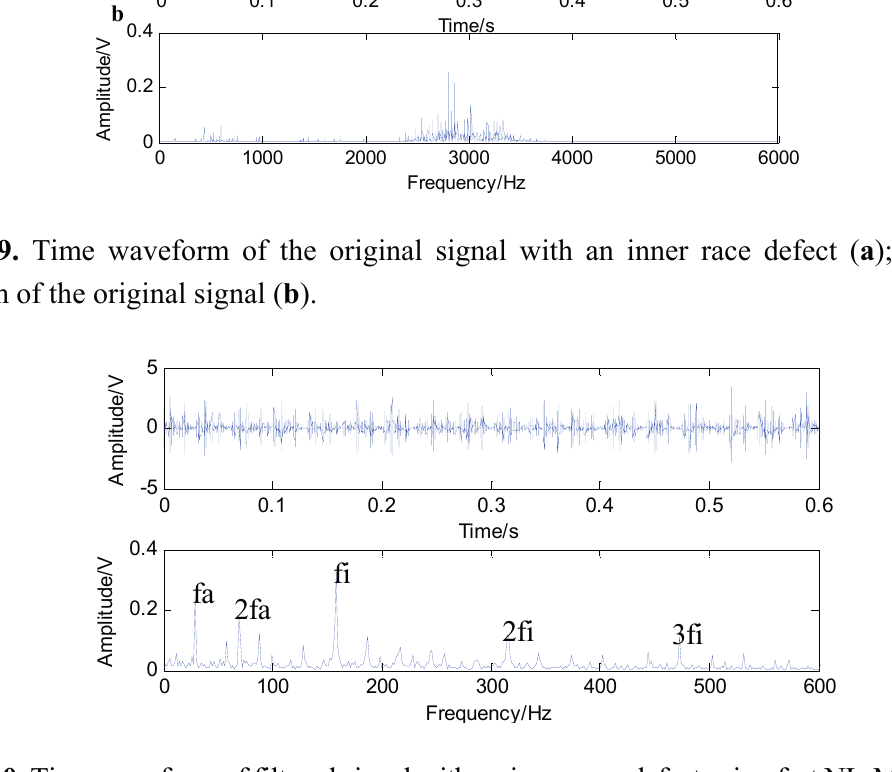
Figure 10. Time waveform of filtered signal with an inner race defect using fast NL-Means ( a ); and the envelope spectrum of the filtered signal ( b